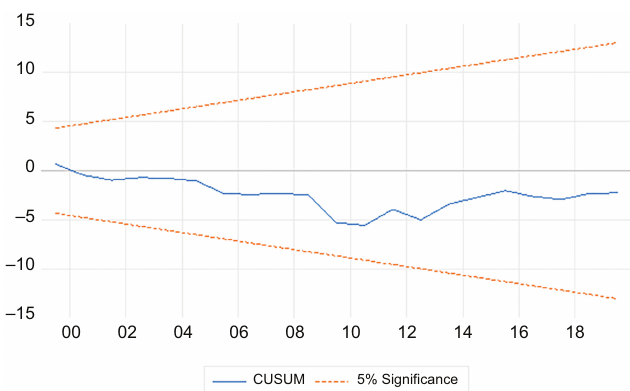
Figure 1. Cumulative